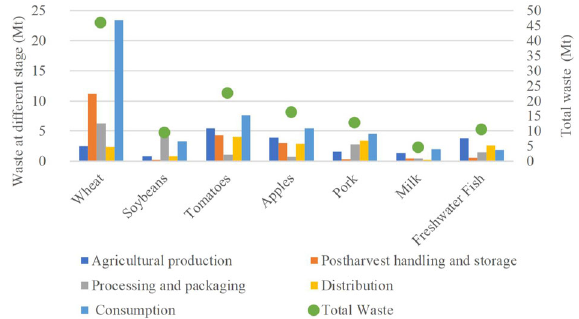
Fig. 2 Average waste by stage across seven food categories in China from 2010 to 2019. Quantity (labels on left) and total quantity (labels on left) of food waste in China for each of the seven food categories (labels in the middle) at fi ve different stages (labels on horizontal line). Data in Mt. Data are annual averages for the period 2010 – 2019.